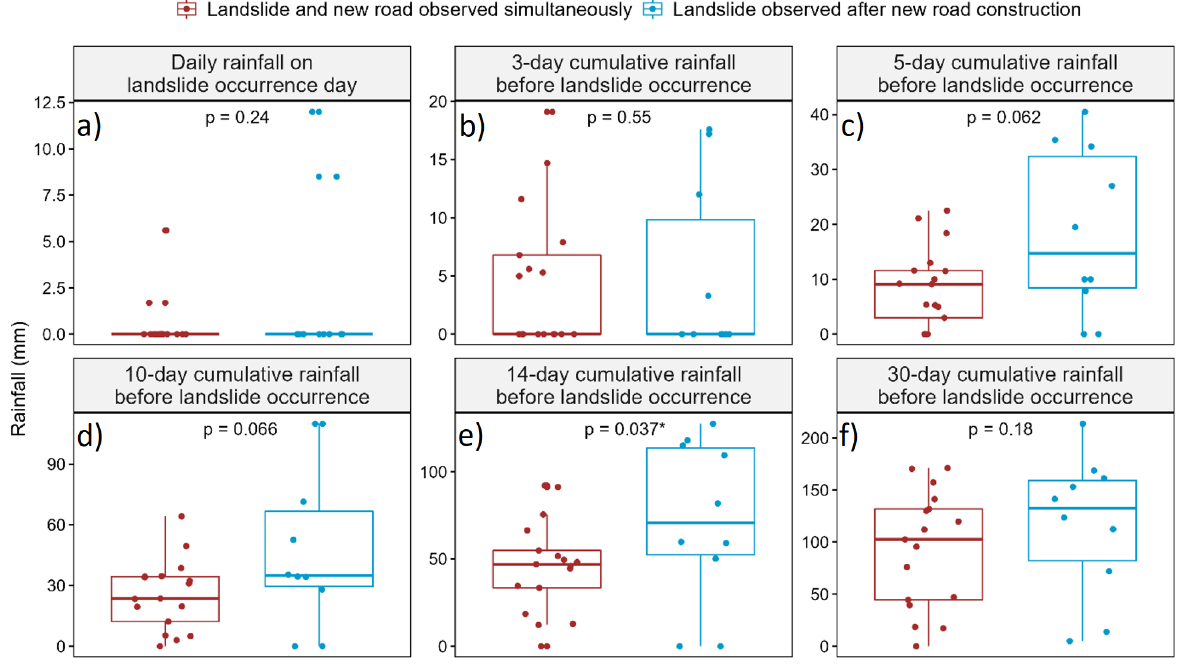
Figure 6. Daily rainfall and cumulative rainfall relation for landslides and road construction observed simultaneously and landslides observed after the new road construction. a) shows the difference per group for the daily rainfall on the day of landslide occurrence, b) for the 3-day cumulative rainfall before landslide occurrence, c) for 5-day cumulative rainfall, d) for 10-day cumulative rainfall, e) 14-day cumulative rainfall, and f) for 30-day cumulative rainfall. The p-value indicates the significance level of the Wilcoxon rank-sum test (p-value < 5% marked with *). The landslide occurrence and road construction dates refer to the first time the landslide or the new road, respectively, was observed on VHR